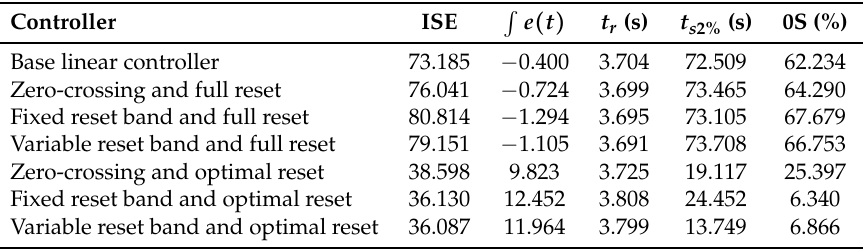
Table 5. Validation characteristics of the controllers.